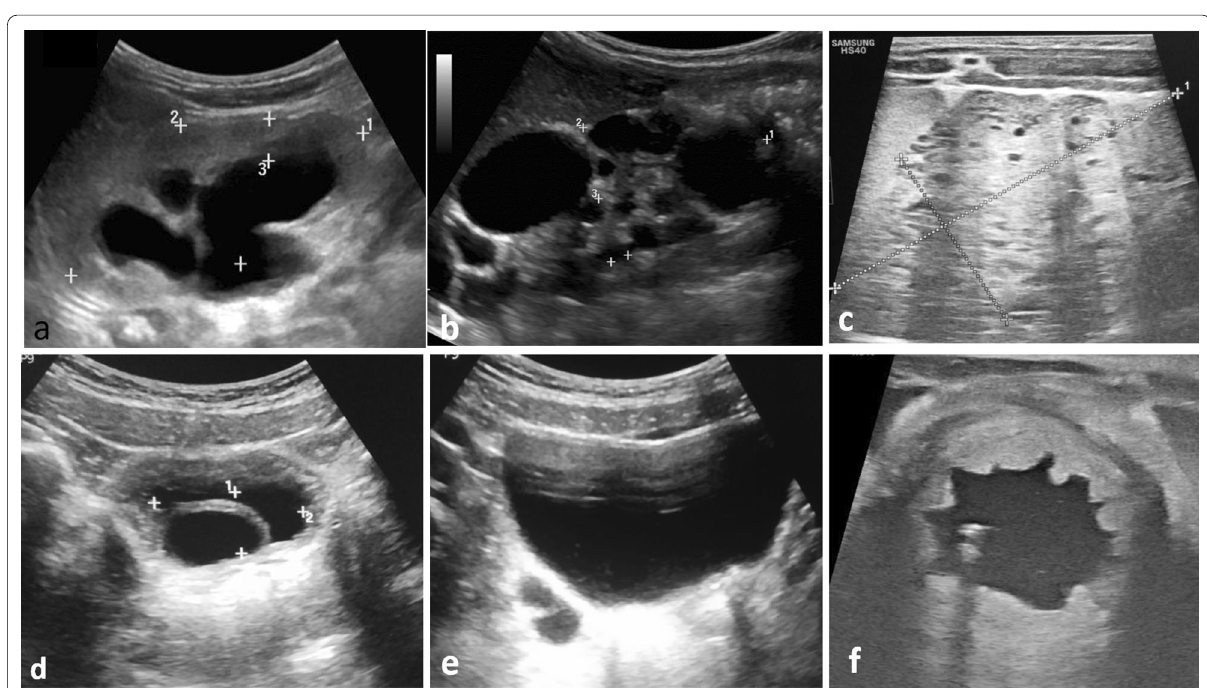
Fig. 1 Value of ultrasound in the initial assessment of the pediatric urinary tract a dilatation of the renal pelvis, central and peripheral calyces with poor corticomedullary differentiation (P3 UTD). b Multiple variable sized cysts in a case of multicystic dysplastic kidney. c Enlarged echogenic kidney with small cysts representing autosomal recessive polycystic kidney disease. d Ureterocele. e Double ureters near the urinary bladder. f Urinary bladder wall thickening and trabeculation in a case of posterior urethral valve